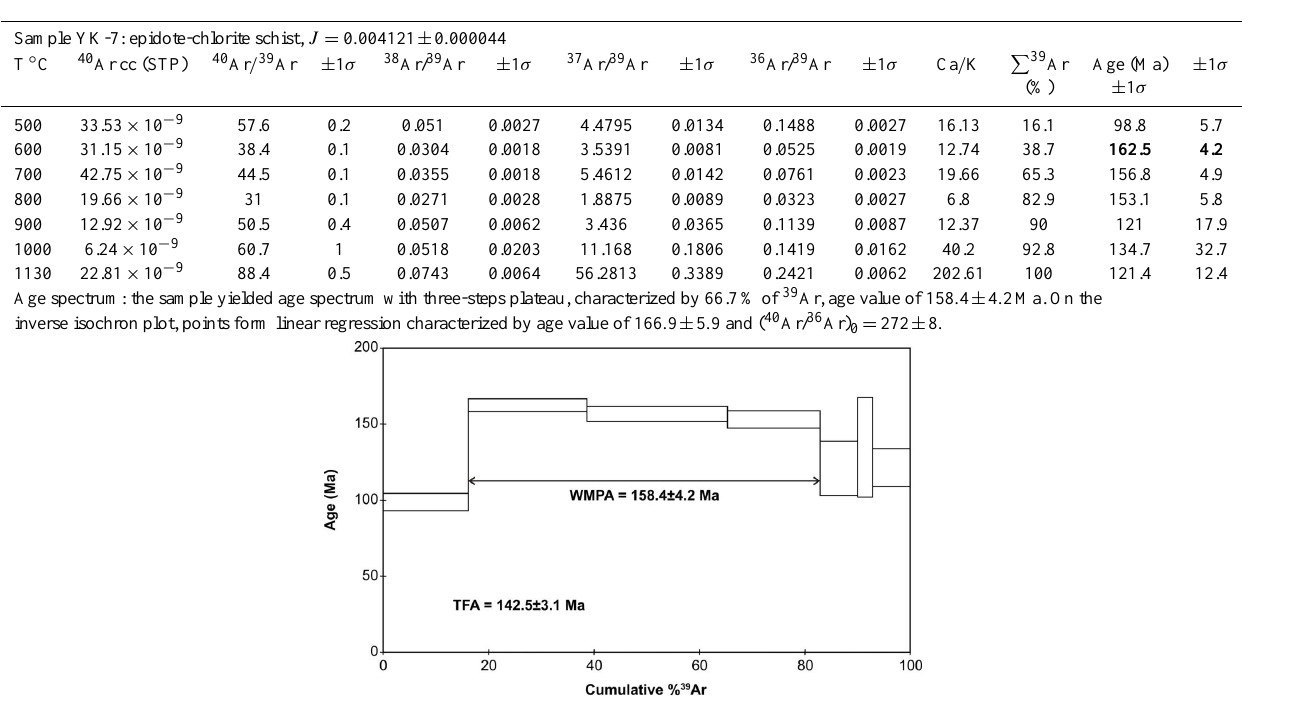
Table 2b. Whole-rock 40 Ar / 39 Ar age data for an epidote-chlorite schist rock from a metamorphic block in the Ankara Mélange, Turkey.